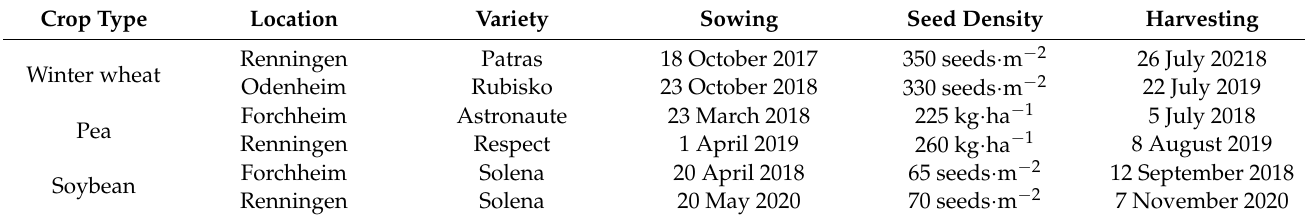
Table 2. Details on cultivation system, crops, sowing, treatments, and harvesting for the presented experimental fields. Crop